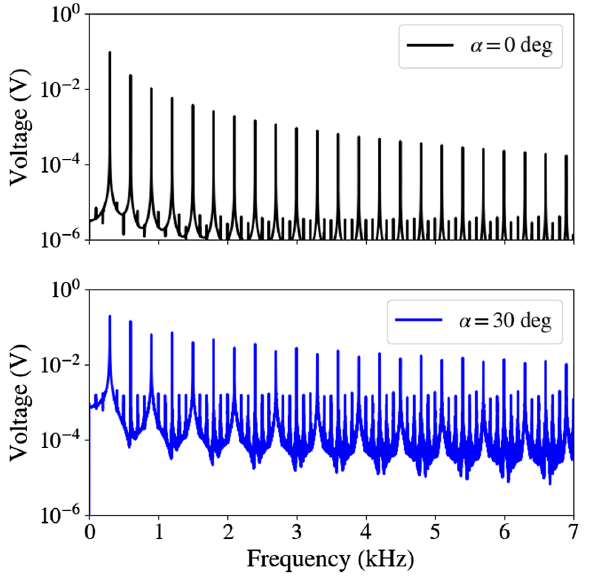
FIG. 25. The frequency spectrum of the SCR rectifier (gray line in Fig. 24) for a firing angle of α ¼ 0 (top) and α ¼ 30 degrees (bottom).